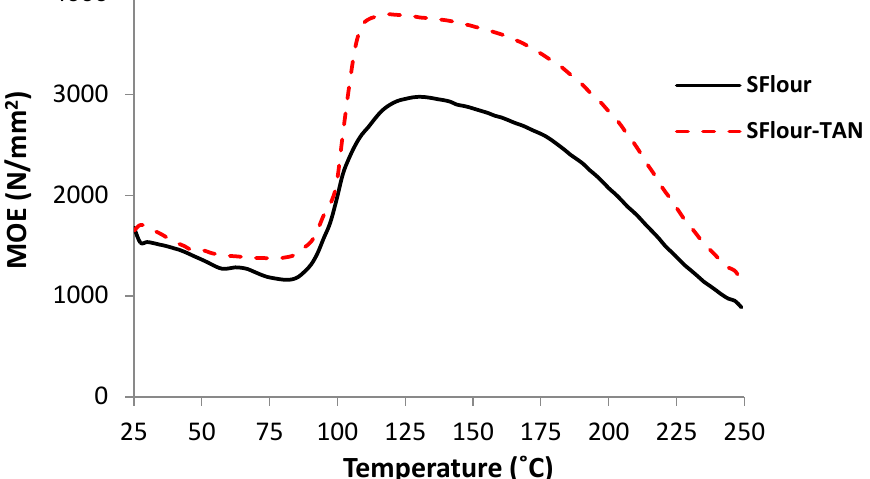
Figure 3. Thermo-mechanical analysis of quebracho tannin–soy flour adhesive. SFlour: Soy flour; TAN: Tannin.